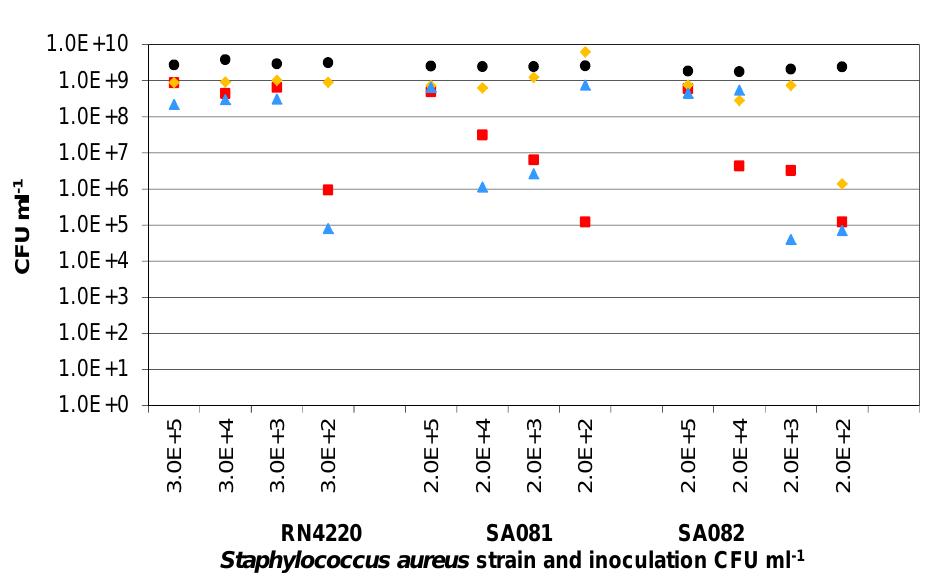
Figure 7. The final numbers of RN4220, SA081 and SA082 with Ag-AgCl sensors after 24 h culturing from different starting densities. Three replicate cultures are shown for each of the three strains of Staphylococcus aureus at each starting density. Sample 1 ( ■ ); Sample 2 ( ▲ ); Sample 3 ( ♦ ); Mean control ( ●